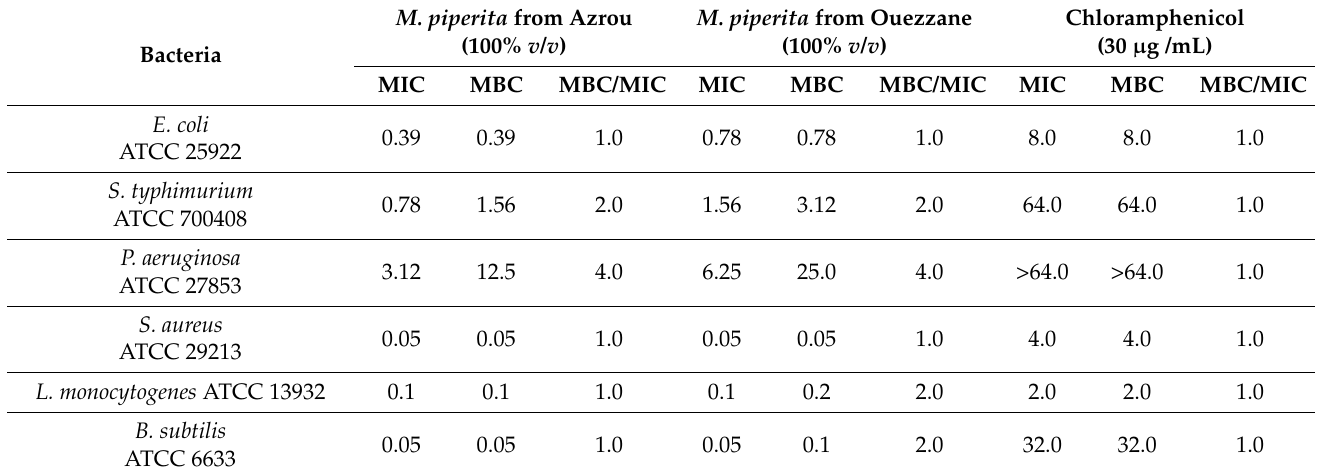
Table 7. The MIC, MBC, and MBC/MIC values of M. piperita EOs from the Azrou and Ouezzane regions.